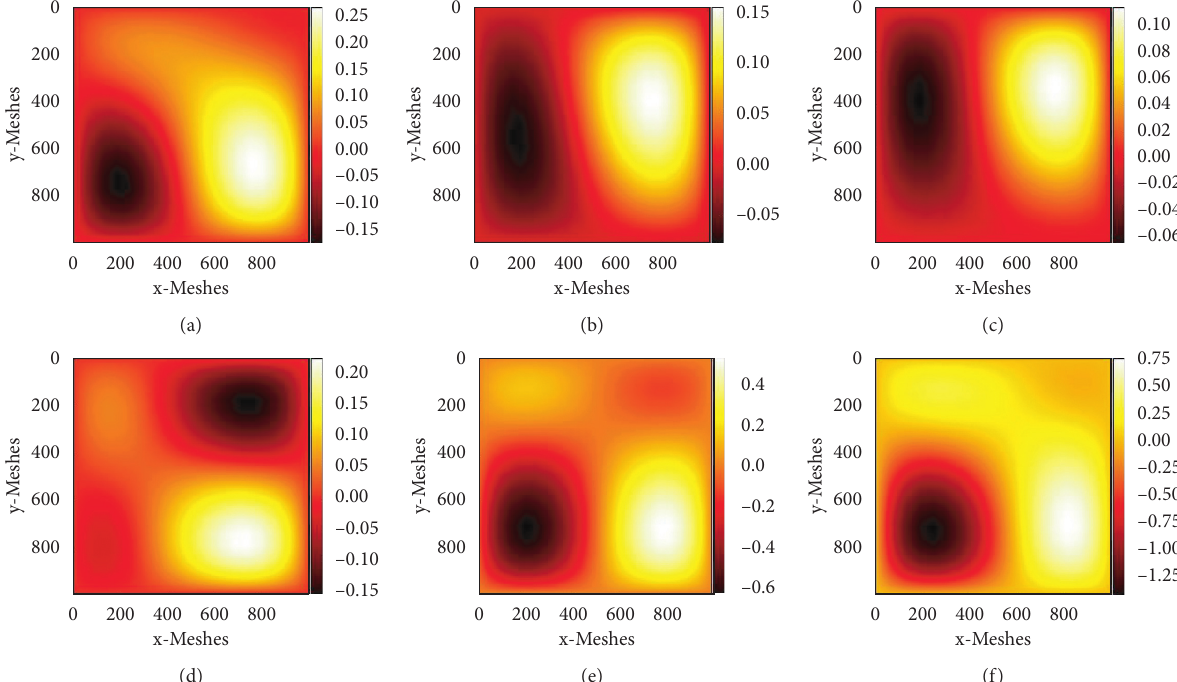
� 5 ,M � M � M , . (a) t � 1.33, α � 0.2. (b) t � 1.33, α � 0.6. (c) t � 1.33, α � 1.0. (d) 1 2 3 4